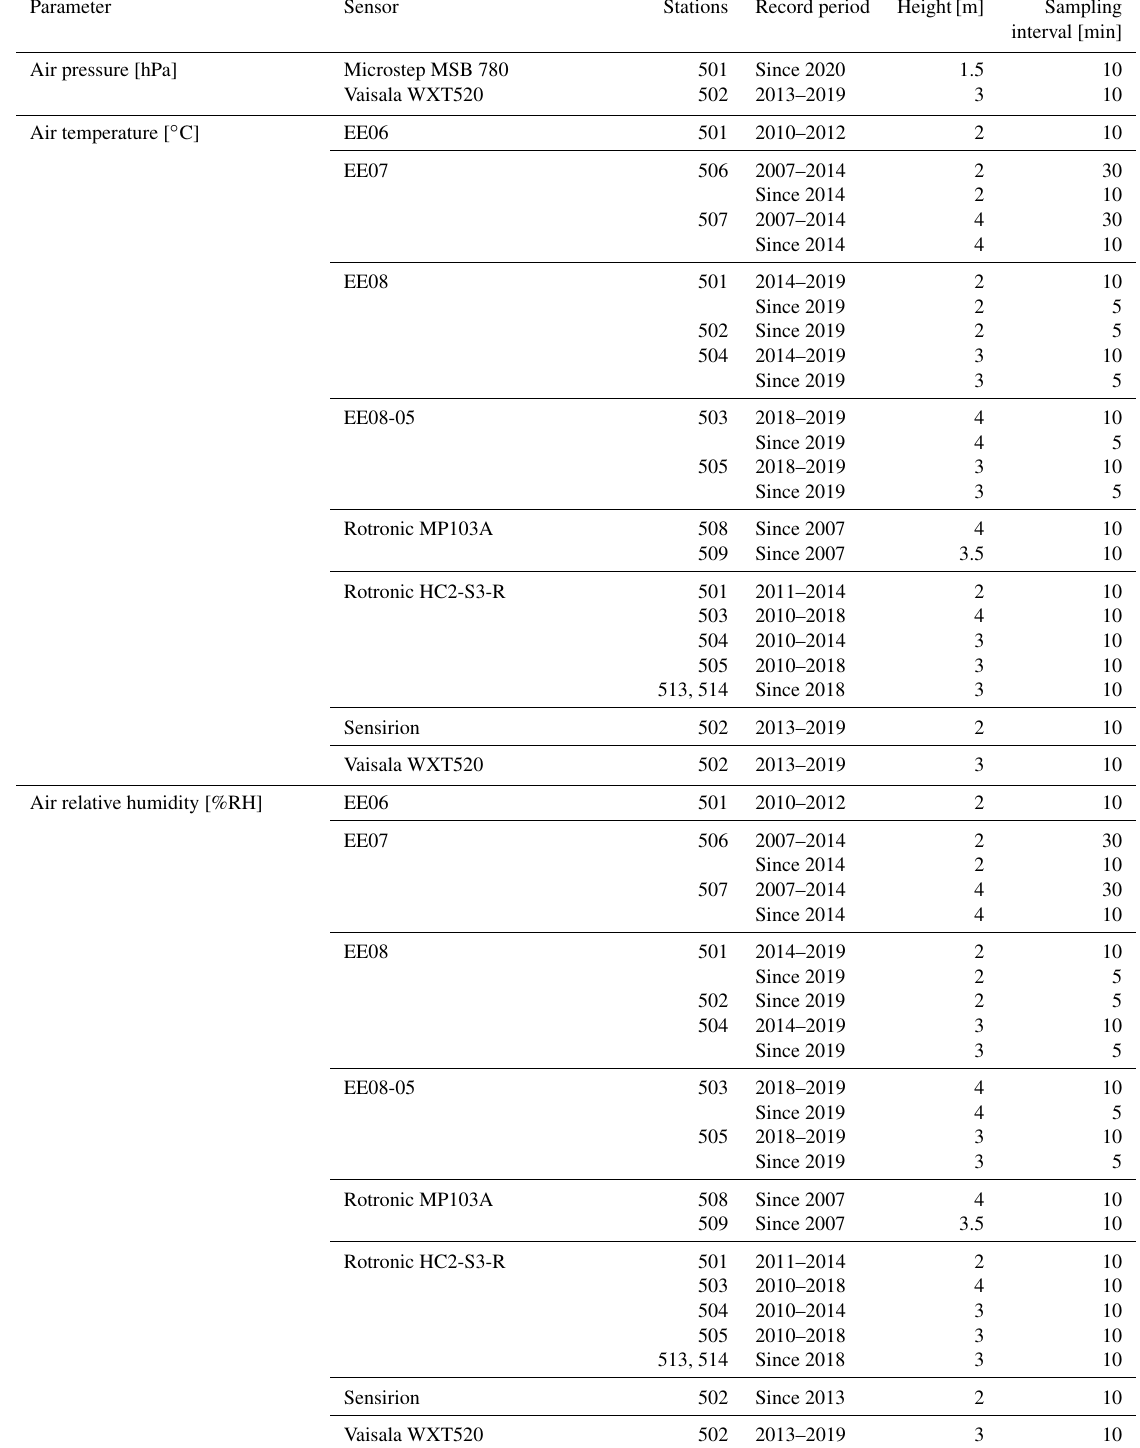
Table A2. Sensors installed in the WegenerNet JBT (alphabetical order by parameter); installed data loggers are stated in the Table’s bottom